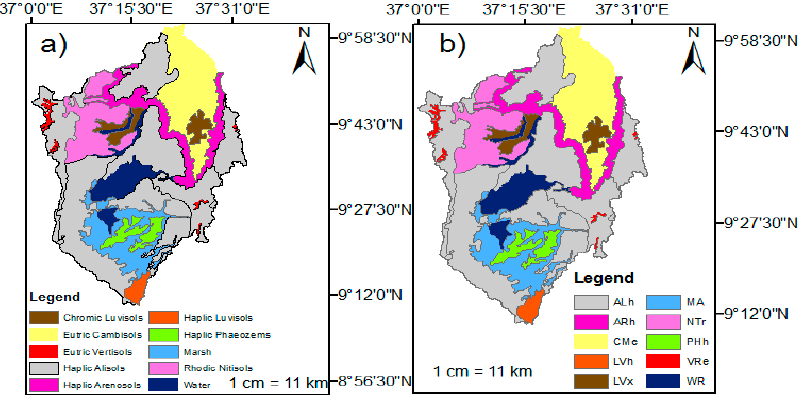
Figure 3. Soil maps of Finchaa catchment ( a ) soil names; ( b ) Soil SWAT code.